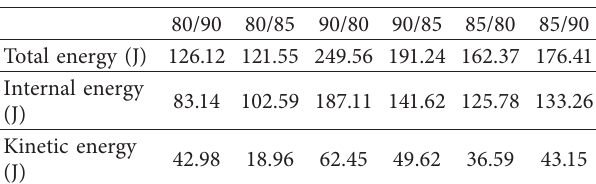
Table 7: Floor energy.